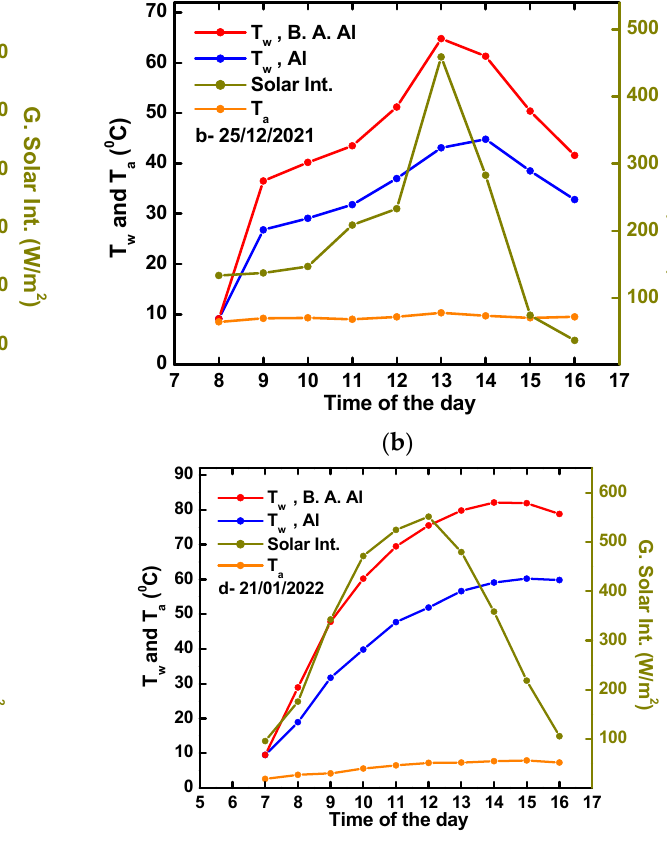
Figure 9. Water and ambient temperatures (T w and T a ) and global solar intensity as a function of the time of day, B. P. Al containers, different starting times, Sunny day, Date: 28 November 2021, Amman, Jordan.